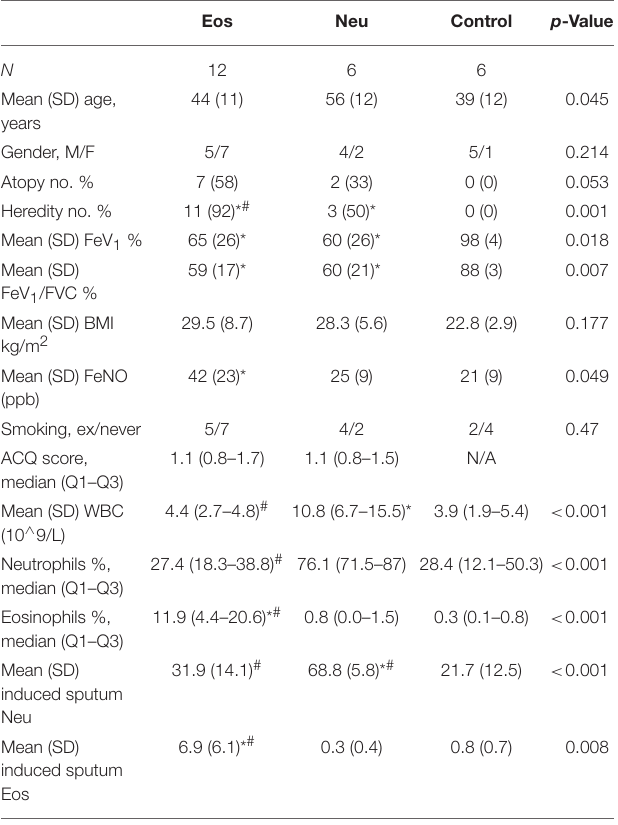
TABLE 1 | Main clinical and laboratory features of the asthma and control